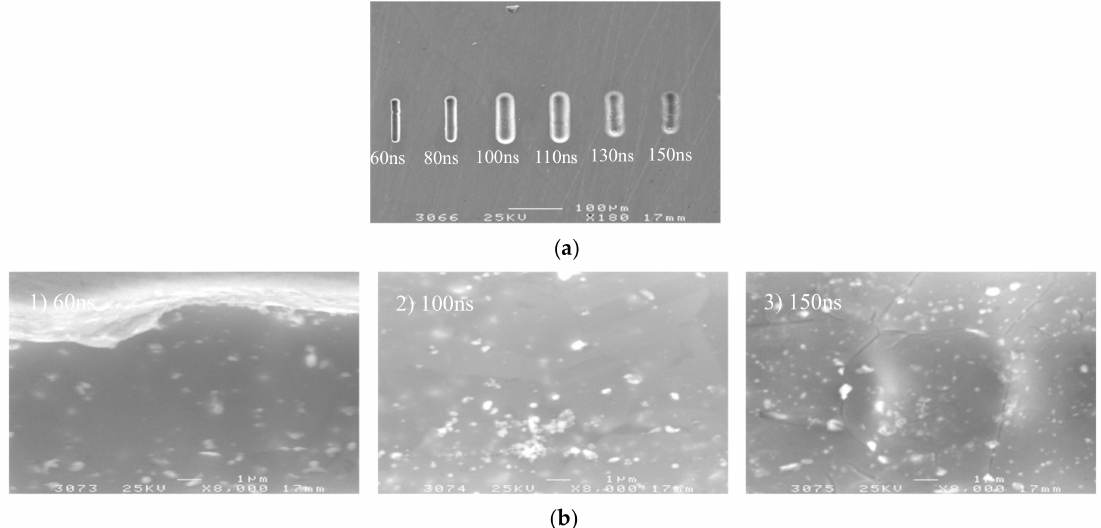
Figure 8. The microgroove under different pulse on times. ( a ) The SEM image of the microgroove; ( b ) The appearance of the